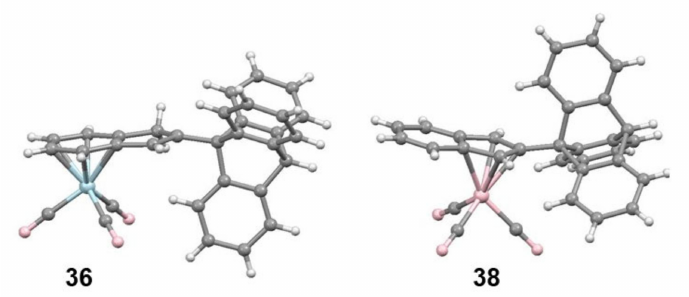
Figure 16. Structures of [ η 6 -2-(9-triptycyl)indene]tricarbonylchromium, 36 , and [ η 5 -2-(9- triptycyl)indenyl]tricarbonylrhenium, 38